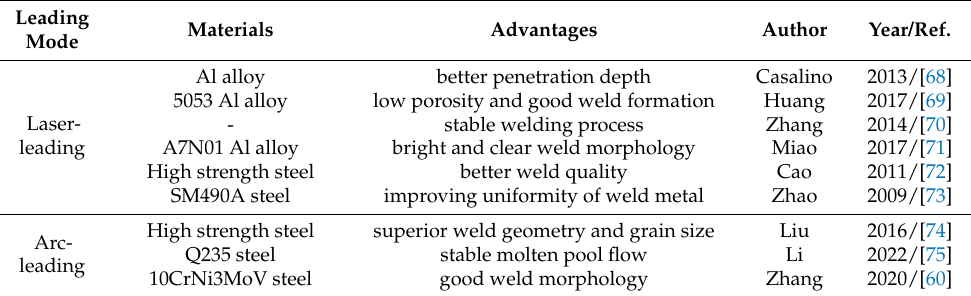
Figure 11. The schematic diagram of heat source position: ( a ) Laser after the arc; ( b ) Laser before the arc. Table 2. The advantages of different heat source-leading modes in this review.